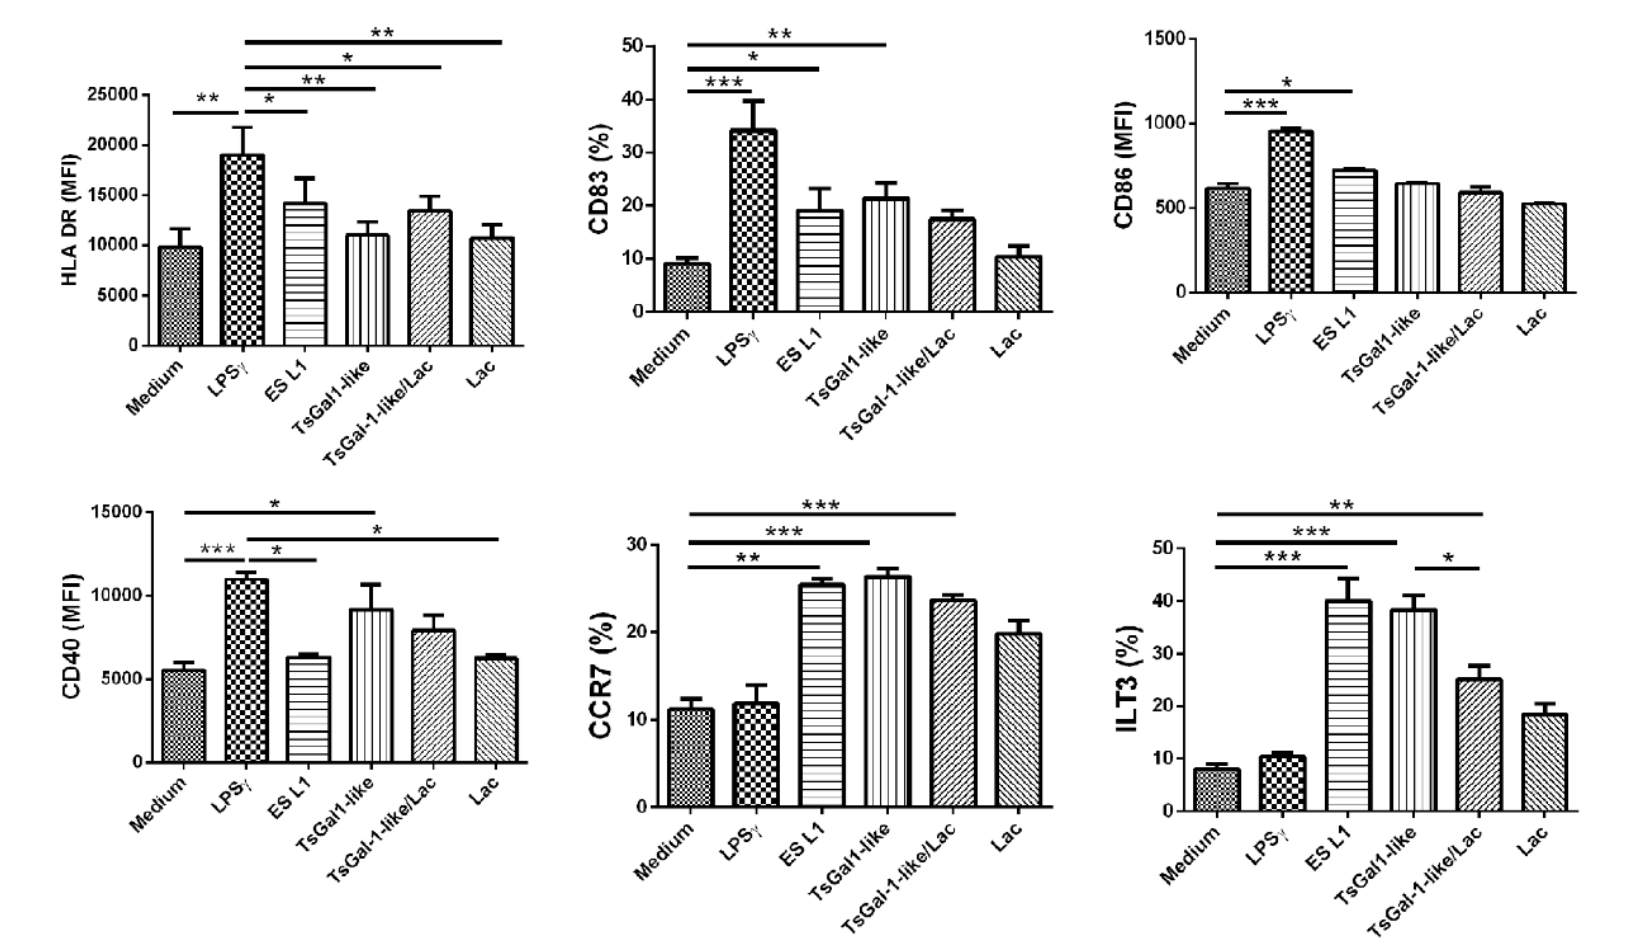
Figure 3: Phenotype of DCs treated with TsGal-1-like proteins . Immature DCs were treated with T. spiralis ES L1 antigens (50 μg/ml), TsGal-1-like proteins (5 μg/ml) and LPS/IFN  and the expression of maturation markers was analyzed by flow cytometry. The summarized results of HLA-DR, CD83, CD86, CD40, CCR7 and ILT3 expression by DCs are shown as mean ± SD from three different experiments. (Representative experiment for the expression of maturation markers is given in Supplementary Figure 1). *p < 0.05, **p < 0.01, ***p < 0.005 compared as indicated (one-way ANOVA with Tukey’s